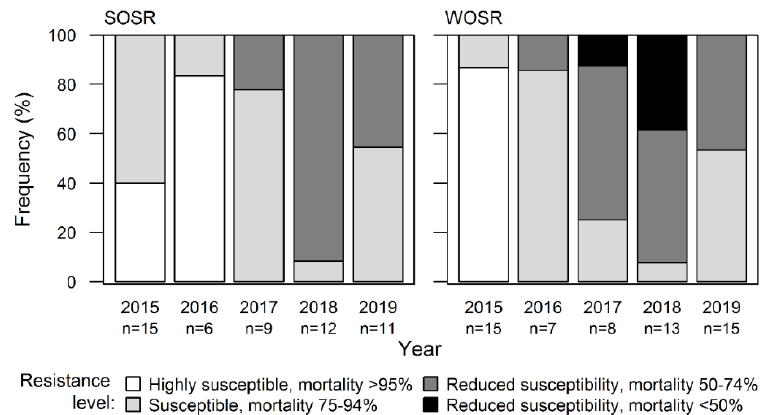
Fig. 3. The distribution of pollen beetle populations against thiacloprid according to resistance levels by years and host crops, classified according to IRAC No 021 (IRAC 2015), and Kaiser et al. (2018). Mortality rates at a dose level of 1.44 µg cm -2 (SOSR: spring oilseed rape; WOSR: